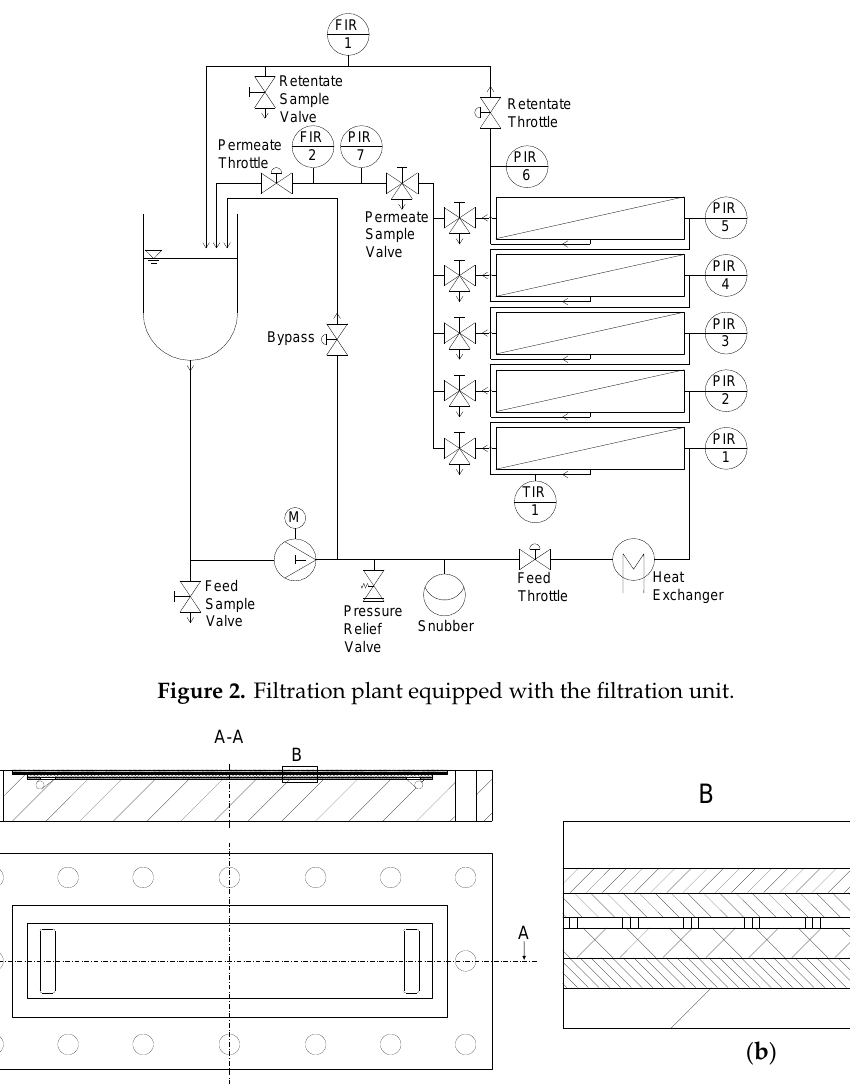
Figure 3. Architecture of a single test cell ( a ). Detail B shows the di ff erent inlays in the test cell during a filtration test ( b ).